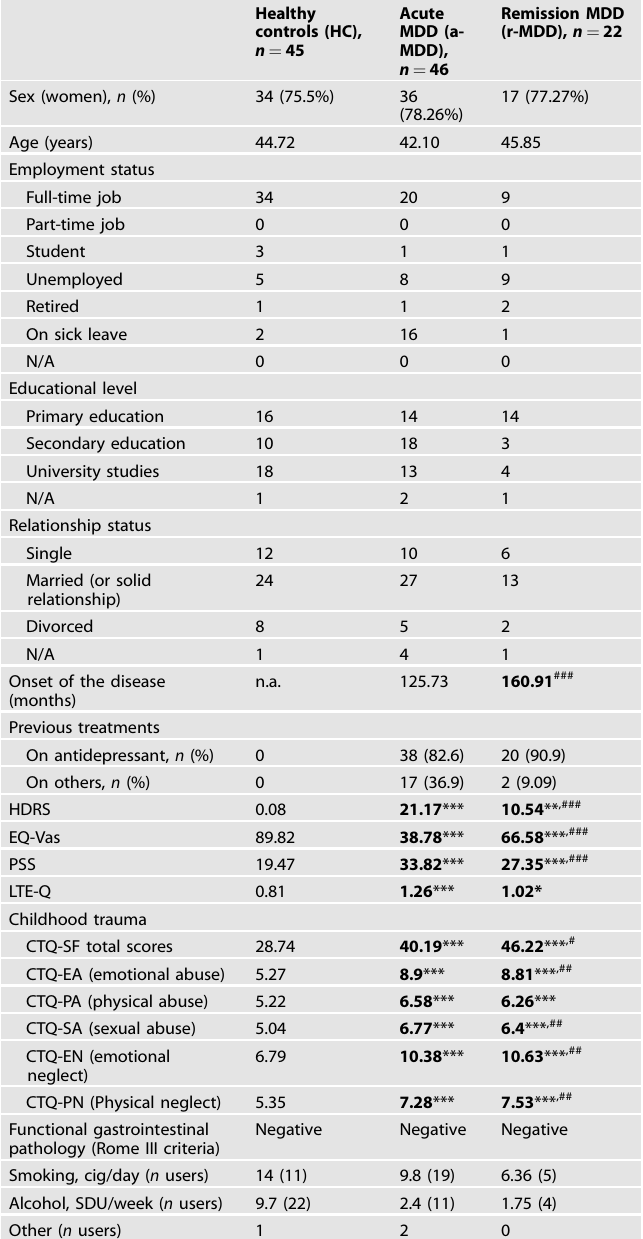
Table 1. Sociodemographic and clinical characteristics of the